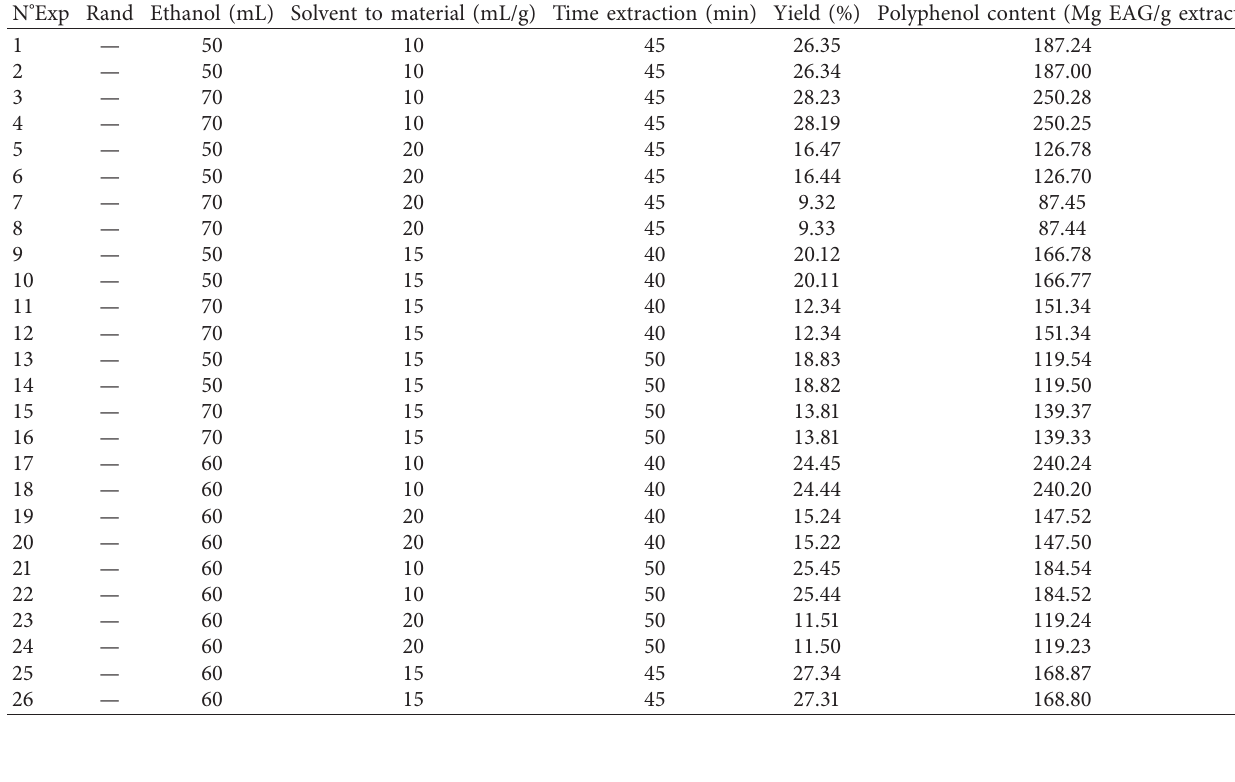
Table 2: Box–Behnken design (coded) arrangement for extraction of Z. mays hairs.